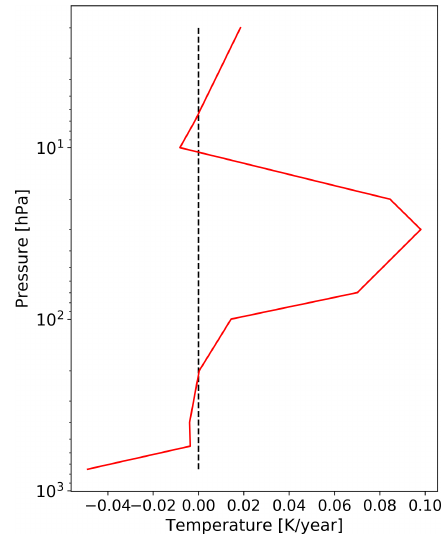
Figure A4. IASI temperature trend at DDU from 2008 to 2020. Adapted from Bouillon et al.